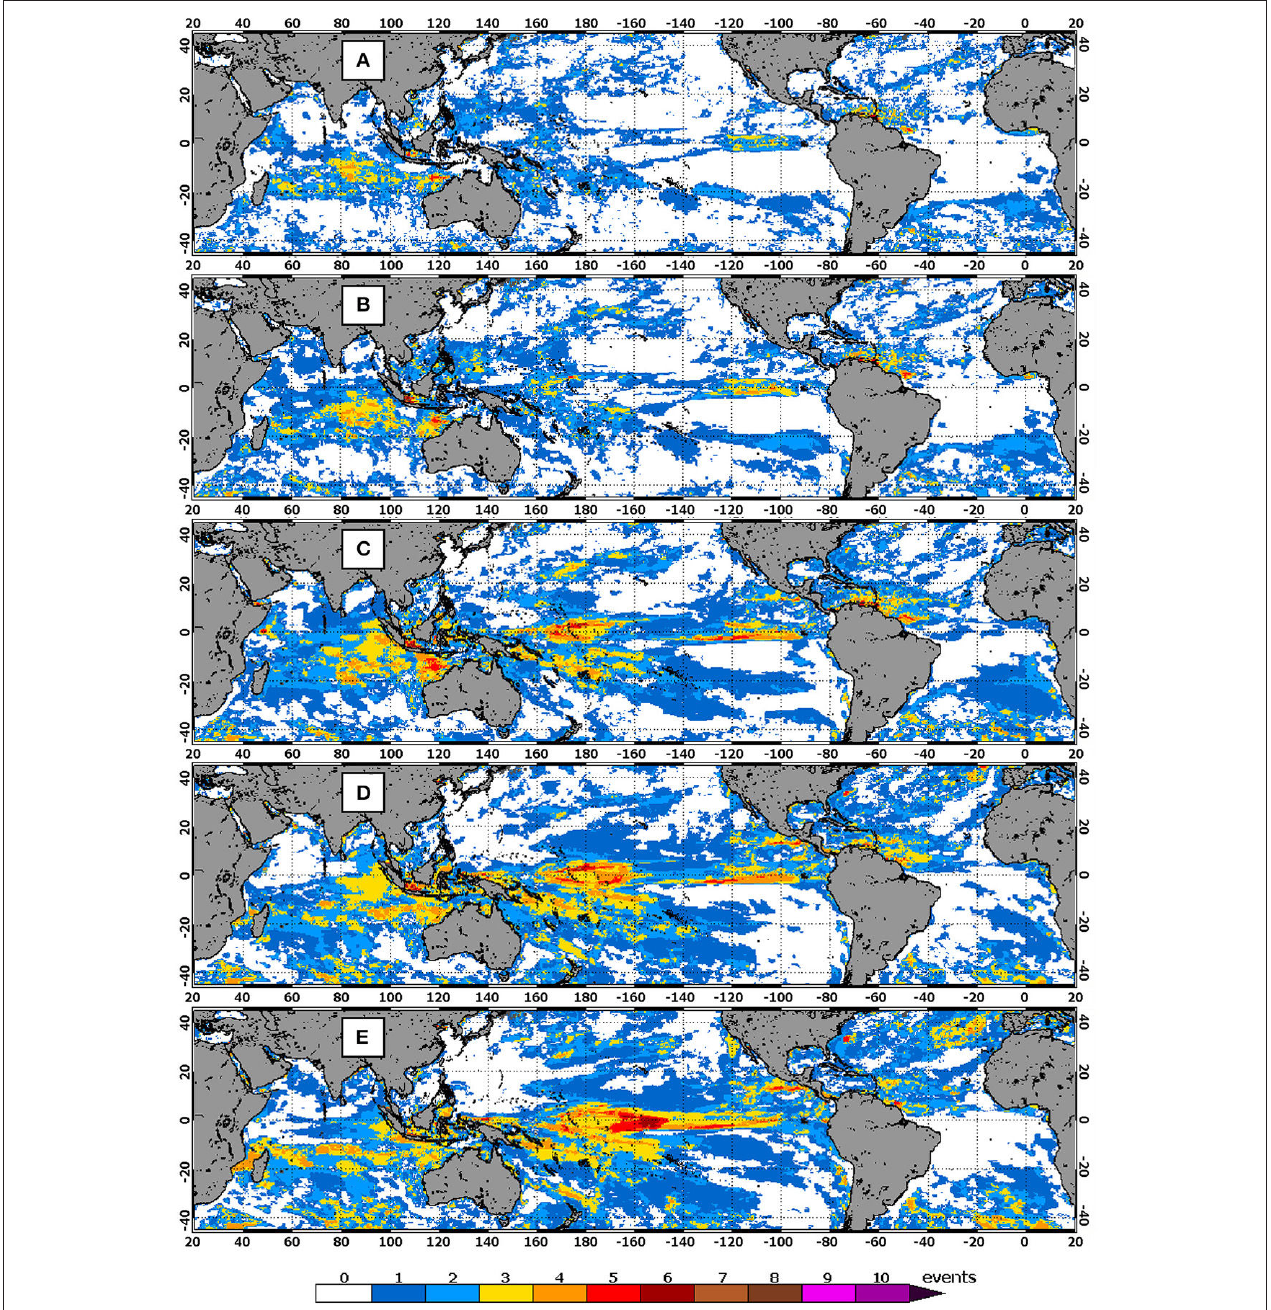
FIGURE 8 | Numbers of false alarms by CRW’s weekly Outlooks (Version 3) of 60% probability during the comparison time period of August 1, 2011–December 27, 2015 for lead-times of: (A) 3-weeks, (B) 5-weeks, (C) 9-weeks, (D) 13-weeks, and (E)